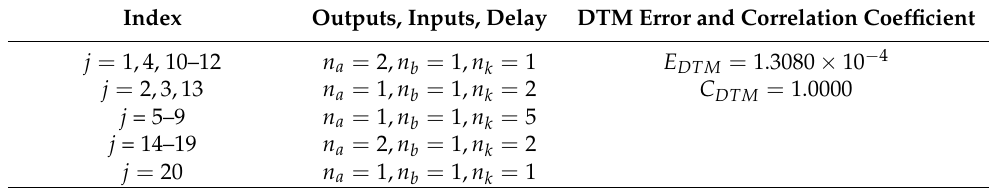
Table 3. Initial data for NLARX estimator of temporal coefficients, case of Re = 10 3 , N DMD = 20.